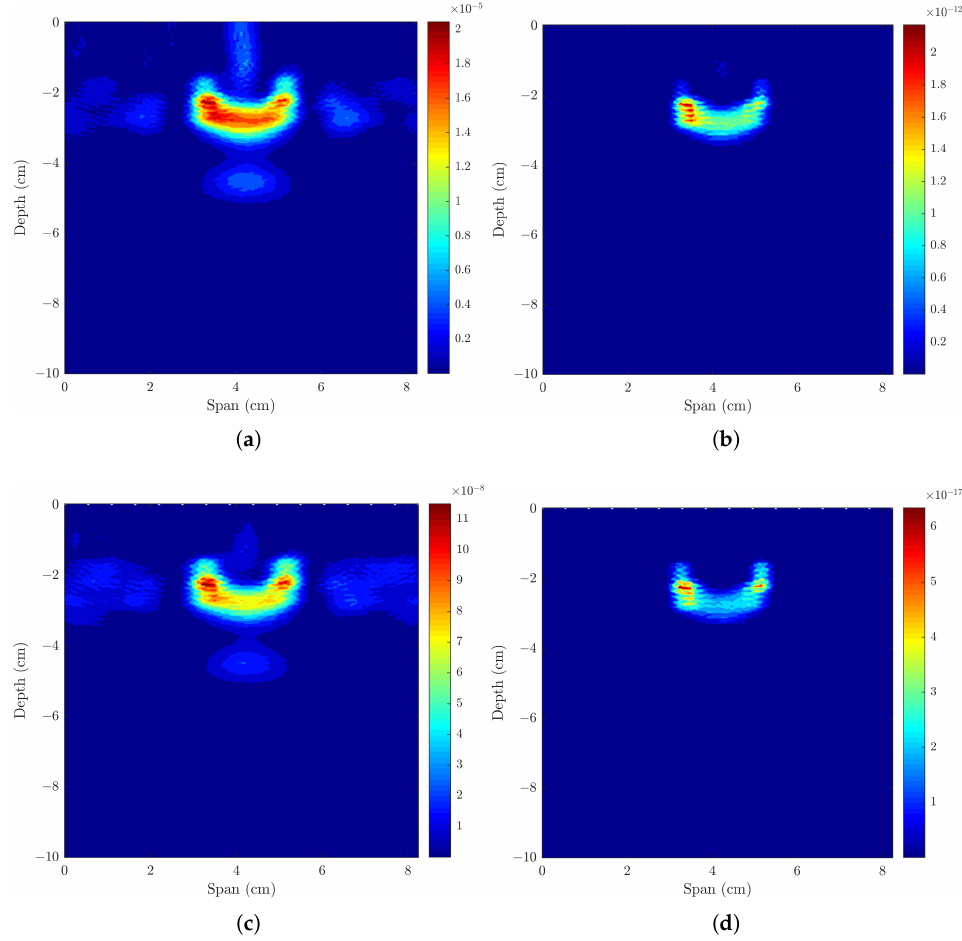
Figure 9. Backscattered energy results from the implemented MWI system of an axillary region model with two metastasized ALNs separated by 7 mm using four different beamformers—( a ) DAS, ( b ) DMAS, ( c ) CR-DAS and ( d ) CR-DMAS—after applying Bond’s artifact removal algorithm. The high intensity regions indicate the detection of the lymph